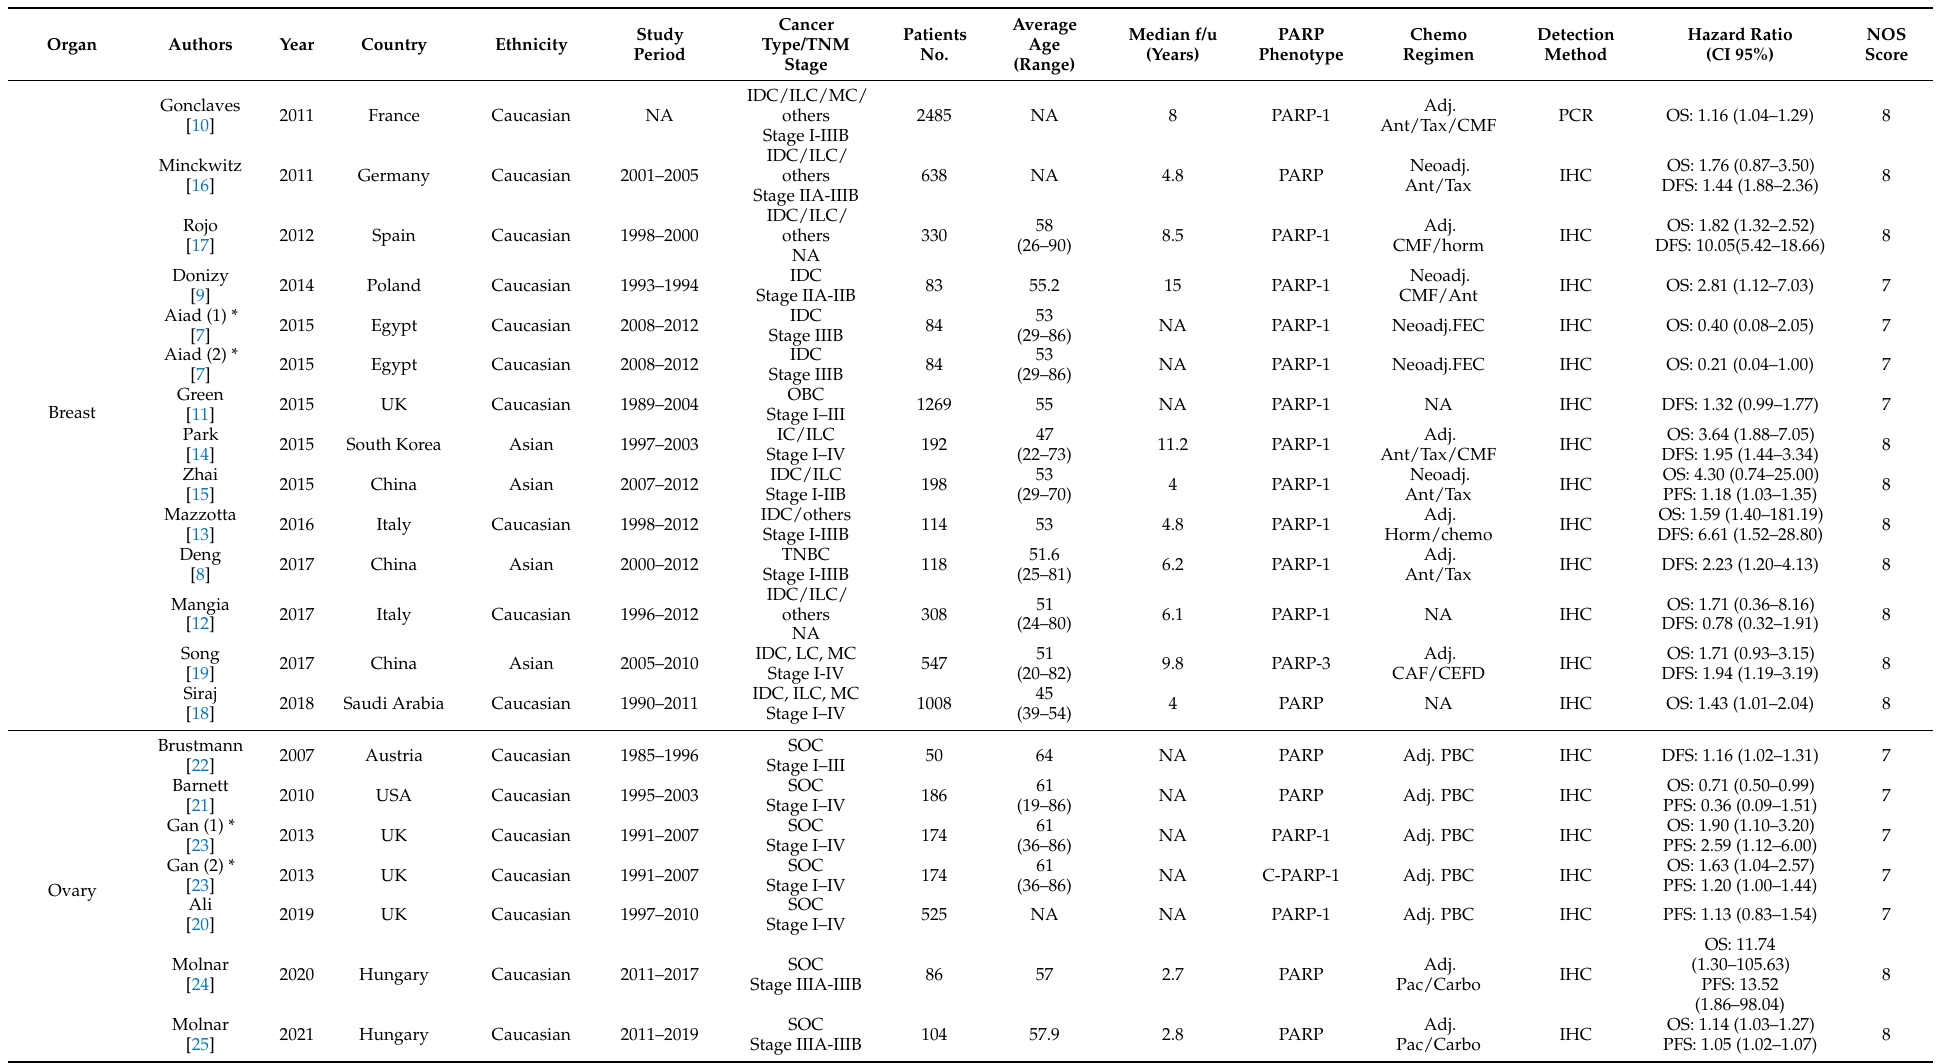
Table 1. Basic characteristics of all the included studies regarding PARPs for this